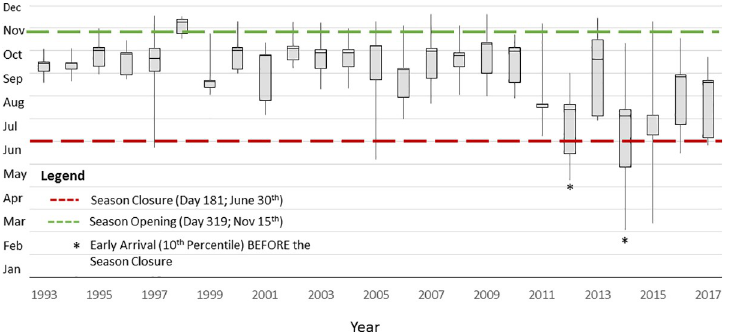
Fig 6. Residency time of humpback whales within 30 km of the Southeast Farallon Islands. The bottom of the box plot corresponds to the arrival time (date of 10 th percentile for the year’s sightings). The top of the box plot corresponds to the departure time (date of 90 th percentile of the year’s sightings). The whiskers are the earliest arrival date (bottom) and the last departure date (top). The red line corresponds to the typical closure of the previous year fishing season on June 30 th (Day 181) and the green line is the typical opening of the new fishing season on November 15 th (Day 319). Years marked with a � correspond to years where there was early arrival.